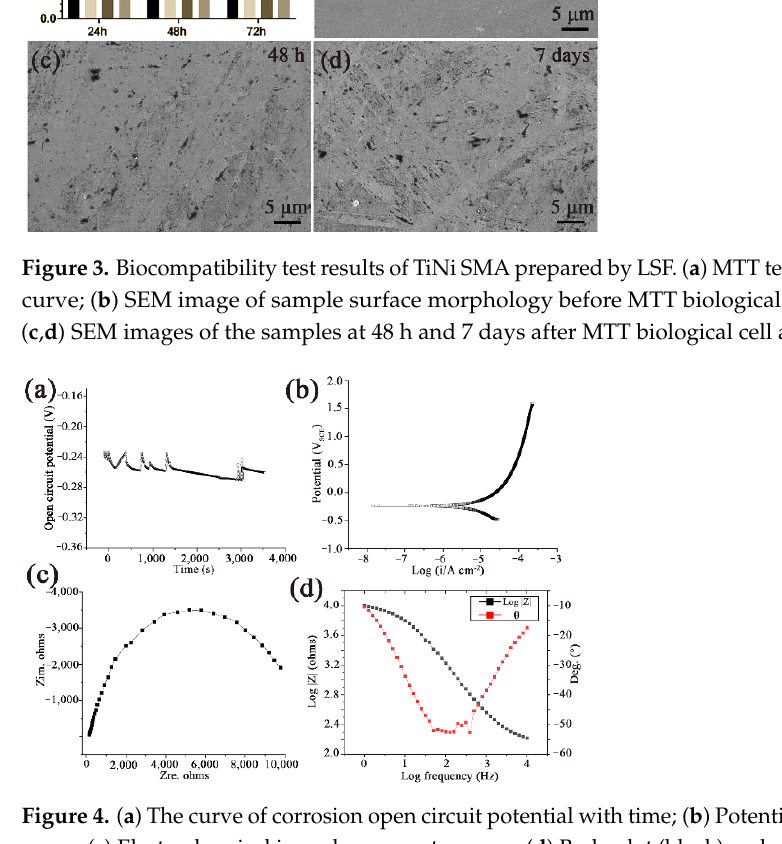
Figure 5. SEM images of the alloy surface ( a ) before and ( b ) after electrochemical corrosion. 4. Conclusions In this paper, the microstructure of TiNi shape memory alloy prepared by laser solid forming was tested by X-ray diffraction, differential scanning calorimetry, and transmis- sion electron microscopy. The microscopic characterization results show that there is a small amount of martensitic slat in TiNi alloy besides the TiNi substrate. The lenticular R phase is densely distributed around the martensitic slat. B2 → R and R → M phase transi- tions occur in the alloy due to the high cooling rate during laser solid forming. The results of the methyl thiazolyl tetrazolium test and the electrochemical corrosion test show that the alloy has good biocompatibility and excellent corrosion resistance and has the poten- tial to be used as a biomedical material. Author Contributions: Writing—original draft preparation, Methodology, R.C.; Writing—review, and editing, Validation, Formal analysis, Y.F.; Writing—review, Data curation, Visualization, K.Y.; Supervision, Investigation, G.Z. All authors have read and agreed to the published version of the manuscript. Funding: This work was financially supported by the National Natural Science Foundation of China (Nos.51871181) and the Key Research and Development Program of Shaanxi Province (No.2021GY- 344). Institutional Review Board Statement: Not applicable. Informed Consent Statement: Not applicable. Data Availability Statement: Not applicable. Acknowledgments: We are deeply grateful to the national Natural Science Foundation of China (No.51871181) and the Key Research and Development Program of Shaanxi Province (No.2021GY- 344) for their support to this work.